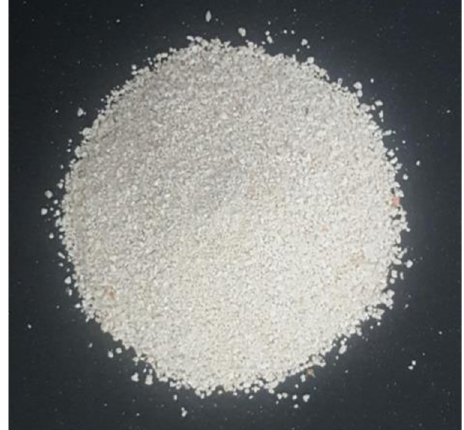
Figure 1. Photo of the tested calcareous sand.